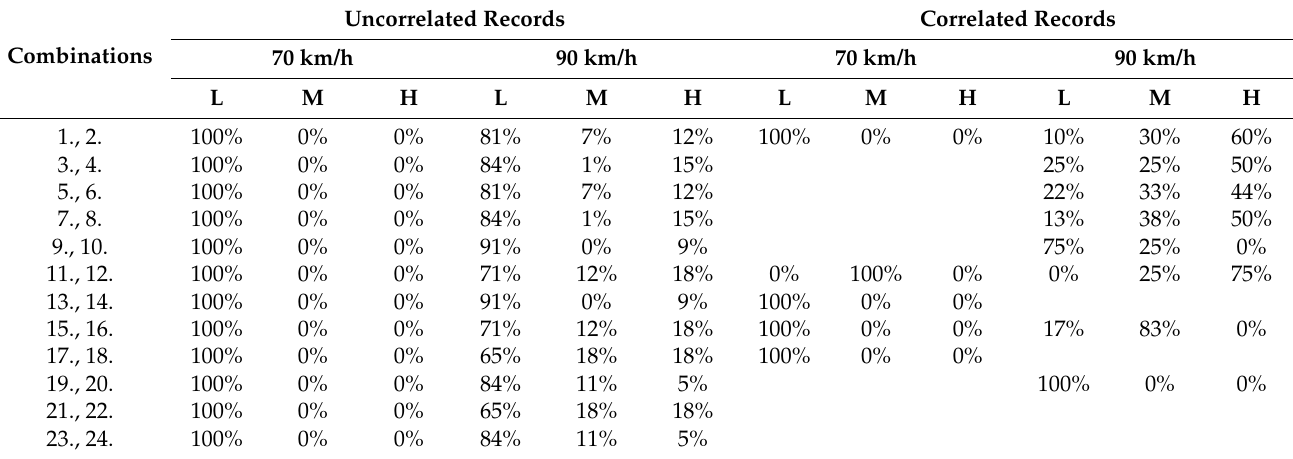
Table 14. Mutual comparison of the probability of each combination for the